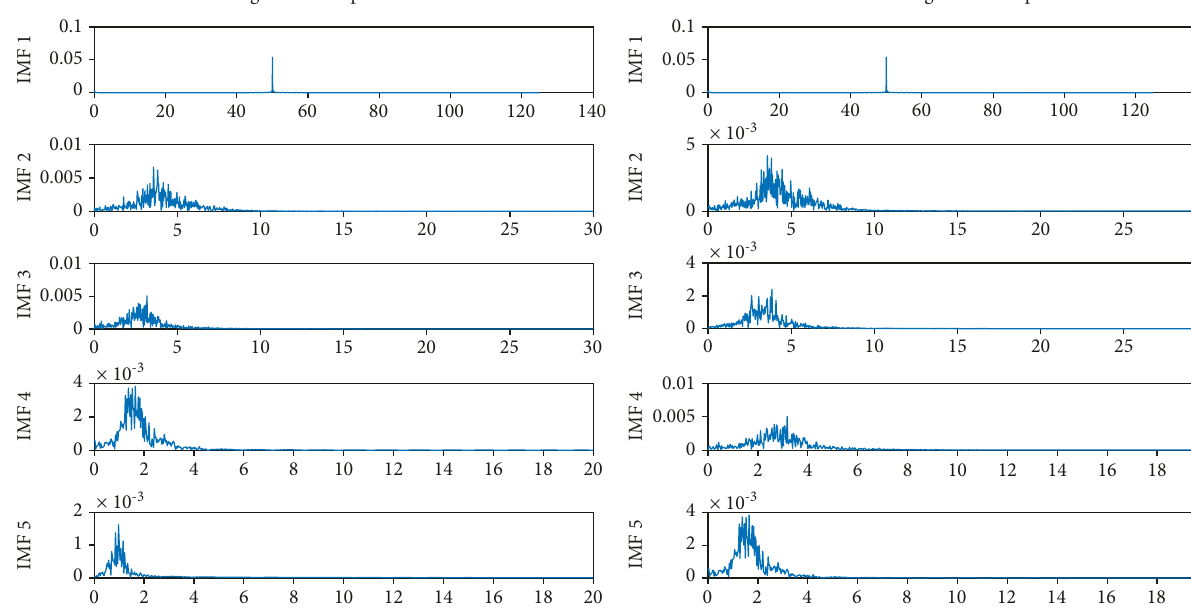
Figure 9: The spectrum of microseismic signals and reconstructed signals based on BPE index with τ = 4